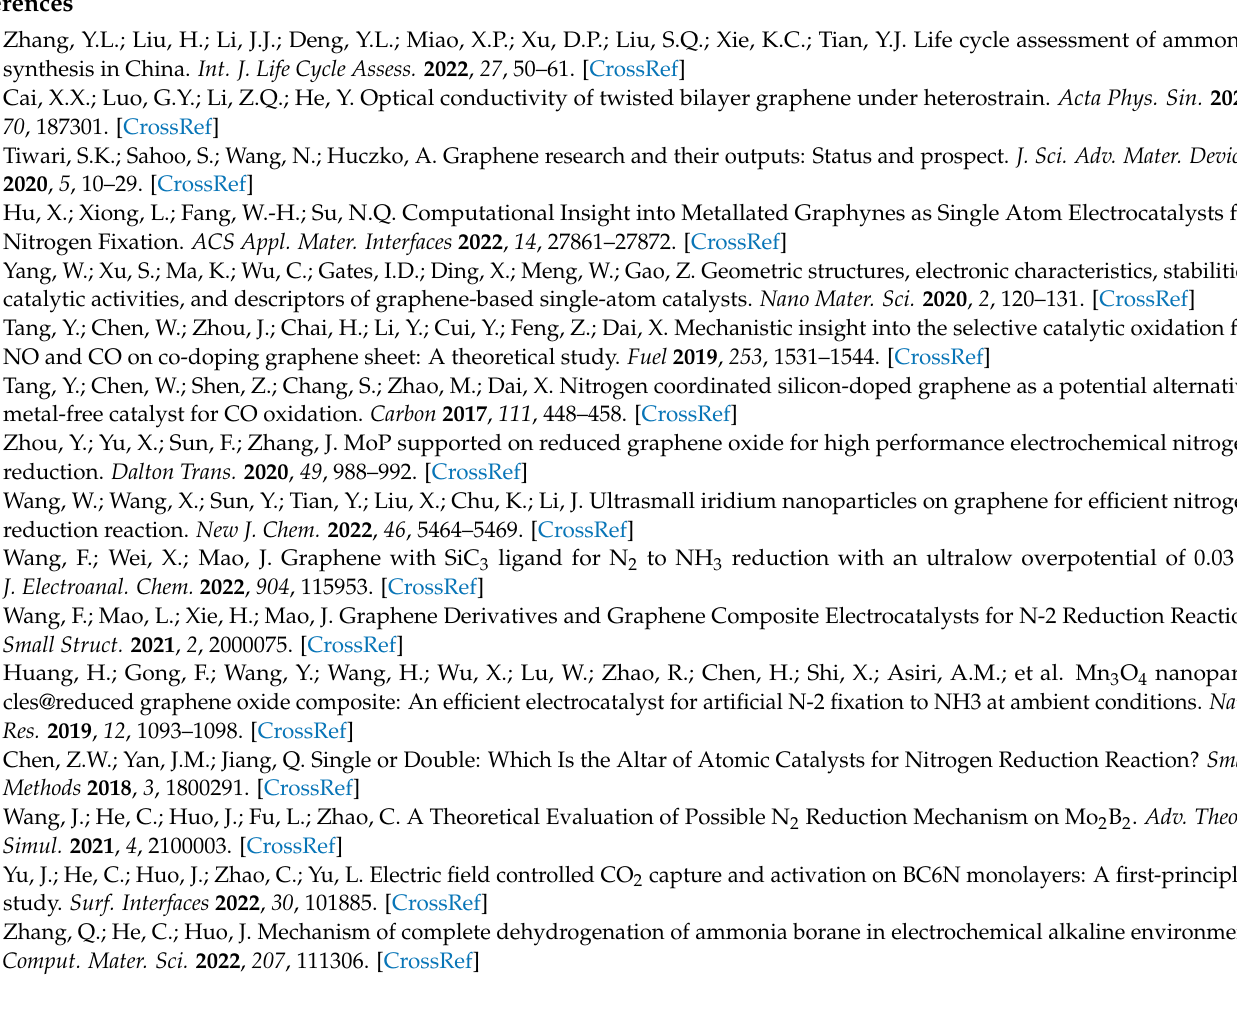
Table S2: Alternate the free energy of each step (eV); Table S3: Change in free energy at alternate steps (eV); Table S4: Alternate Plotting value (eV); Table S5: Ti Alternate Plotting value